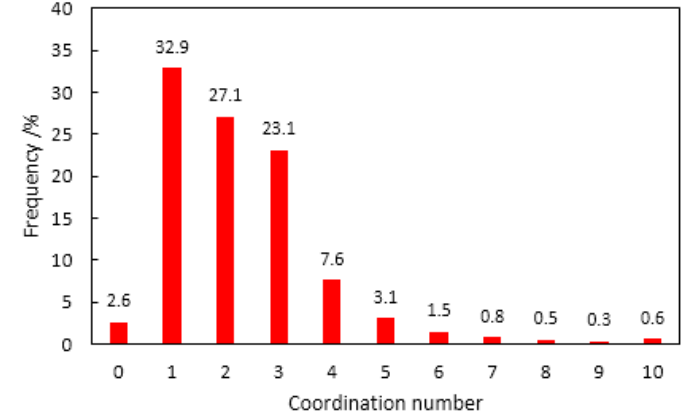
Figure 9. Coordination number for the pores of Chang 7 tight oil reservoir.